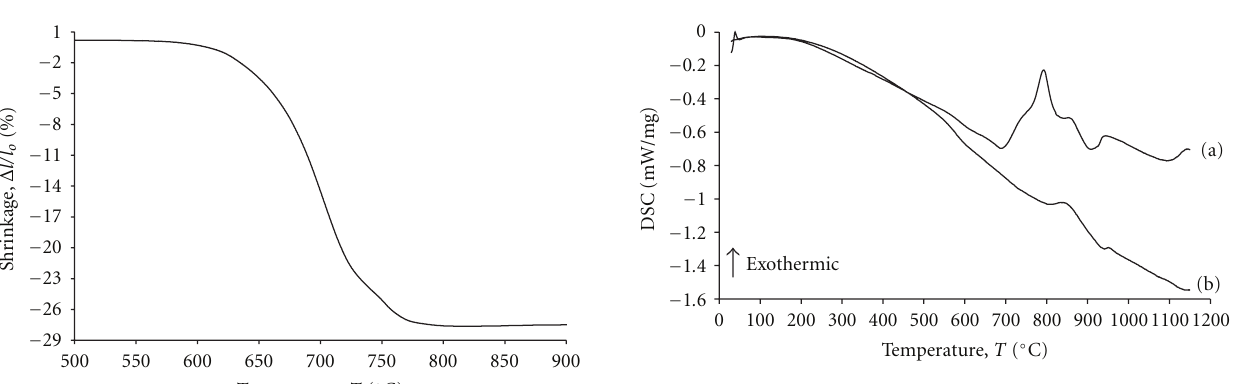
Figure 4: DSC scans at 10 ◦ C · min − 1 heating rate for di ff erent